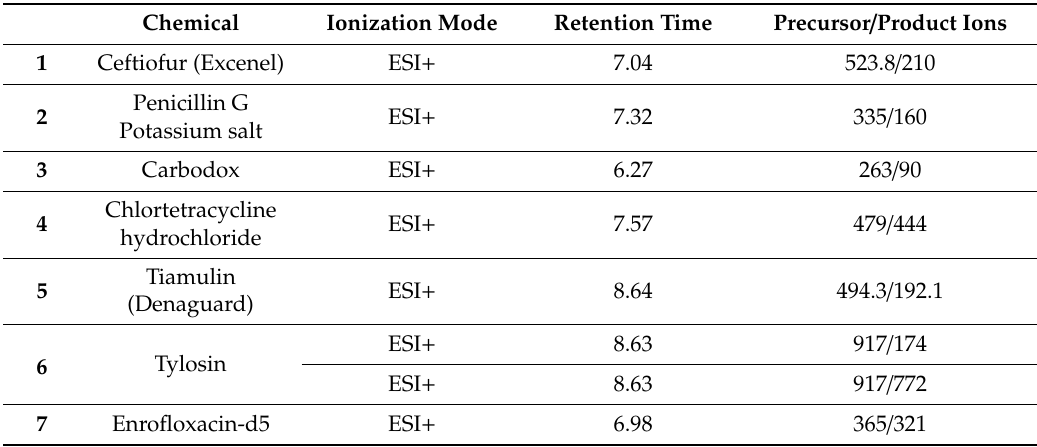
Table 5. The ionization mode, retention times and optimized precursor / product ions for analysis of the VAs by the developed LC-MS / MS